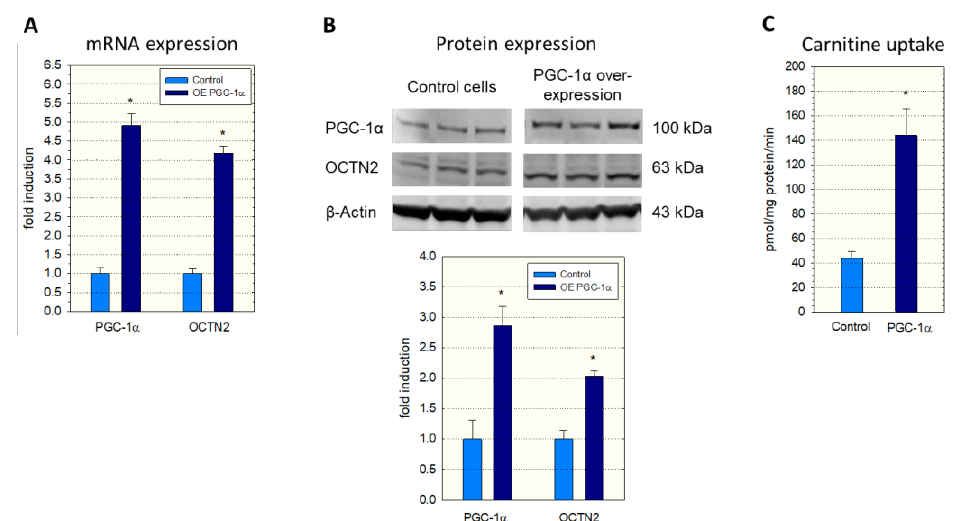
Figure 1. mRNA and protein expression of OCTN2 in and carnitine transport into C2C12 myoblasts with overexpression of PGC- 1α. Overexpression of PGC - 1α was achieved by adenoviral ( A , C ) or lentiviral transduction ( B ). ( A ) mRNA expression, ( B ) Western blot and quantification of the bands, and ( C ) Na + -dependent cellular uptake of 3 H-carnitine. Control cells contained the respective empty vector. Data are presented as the mean ± SD of n = 3 ( A , B ) or 5 ( C ) independent observations. * p < 0.05 vs. control incubations.